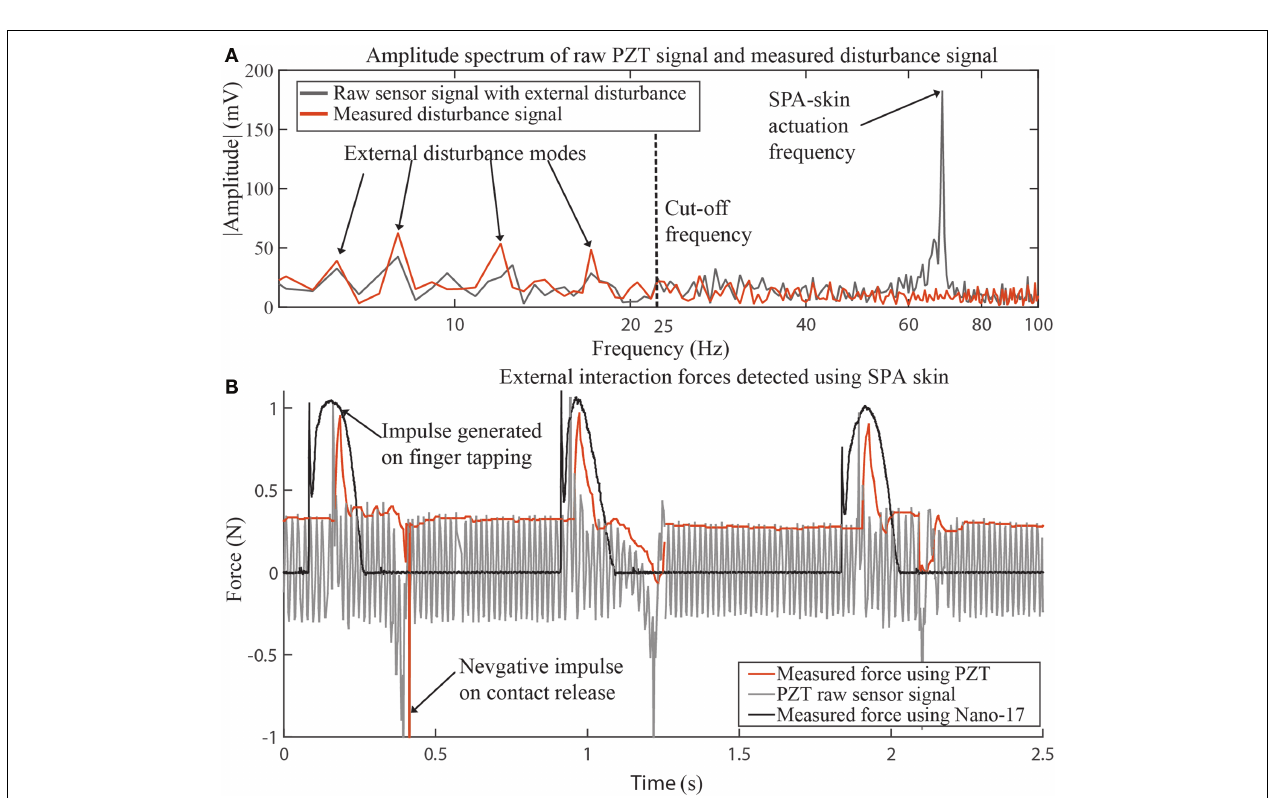
FIGURE 9 | SPA skin external signal detection . Frequency domain representation (A) of raw sensor signal and filtered peak value signal clearly demonstrates the capability to filter actuator vibrations and preserve disturbance signal. The external physical disturbances have interaction frequencies <20Hz. Detection of external interaction due to finger tapping on previously actuated SPA skin at 65Hz (B) . The force sensor data and filtered PZT data in (B) read comparable interaction force on positive impact.